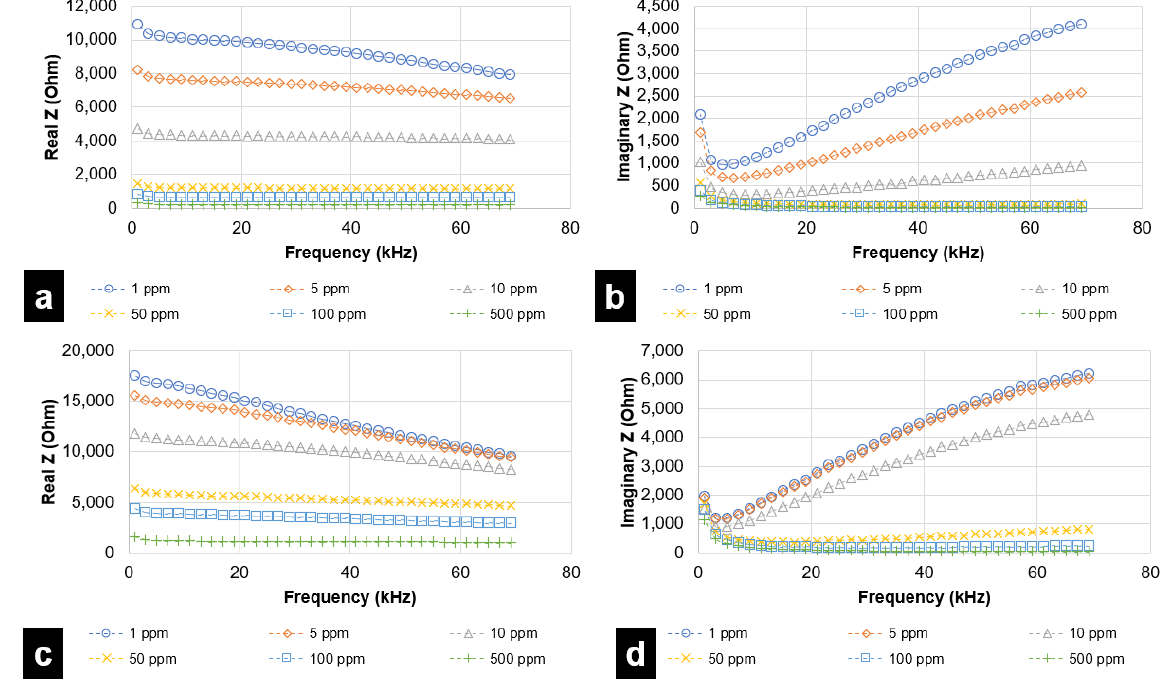
Figure 9. EIS analysis for Citric Acid (sour) and L-tryptophan (bitter), in the range of 1 kHz to 69 kHz, for DLW-photolithography-based IDE sensor in terms of ( a ) Resistive Impedance vs. Frequency (Citric Acid) ( b ) Reactive Impedance vs. Frequency (Citric Acid) ( c ) Resistive Impedance vs. Frequency (L-tryptophan) ( d ) Reactive Impedance vs. Frequency (L-tryptophan).